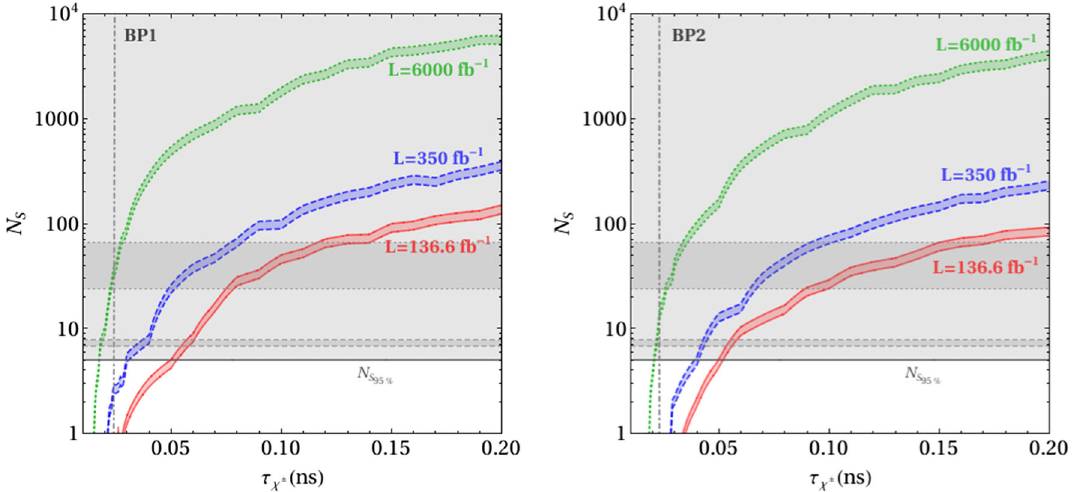
Fig. 4 Number of expected signal events N S as a function of the LL ˜ χ ± lifetime τ ˜ χ ± fortheinertcharginomass242GeV(BP1,leftplot)and I I 273 GeV (BP2, right plot), and for three different values of integrated luminosity at the LHC: 136 fb − 1 (red solid), 350 fb − 1 (blue dashed), and 6000 fb − 1 (green dotted). The vertical dot-dashed line denotes the